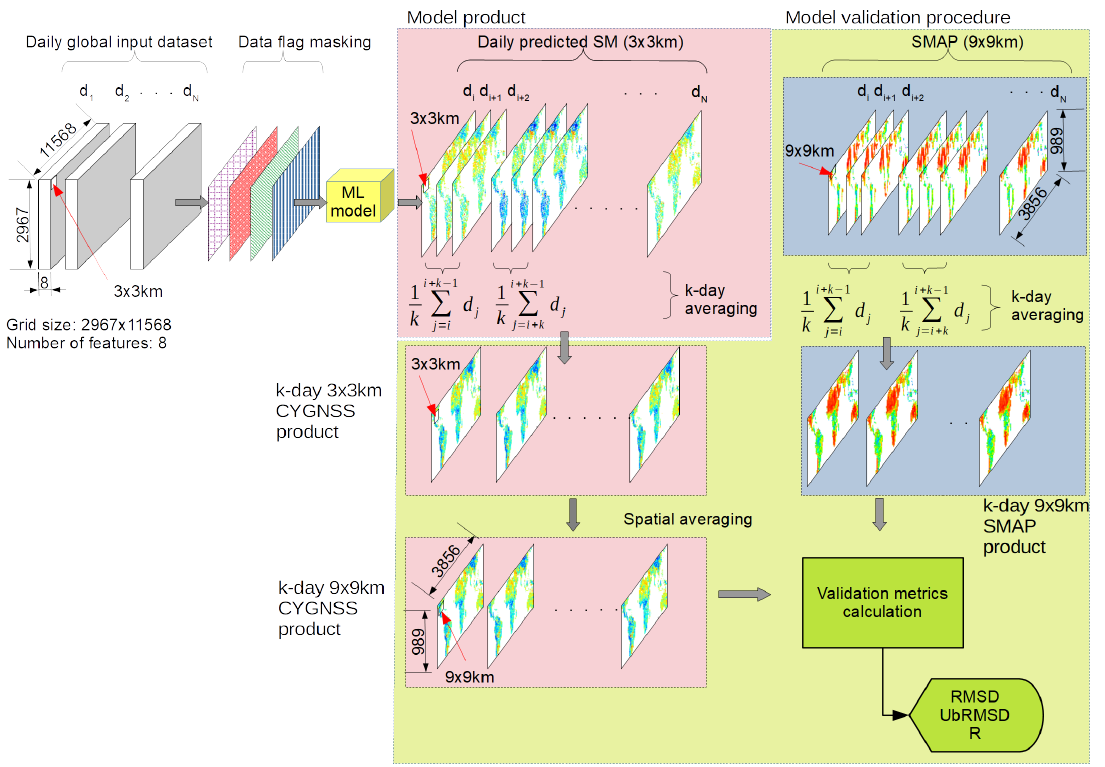
Figure 3. Application of the proposed machine learning (ML) model and k-days evaluation